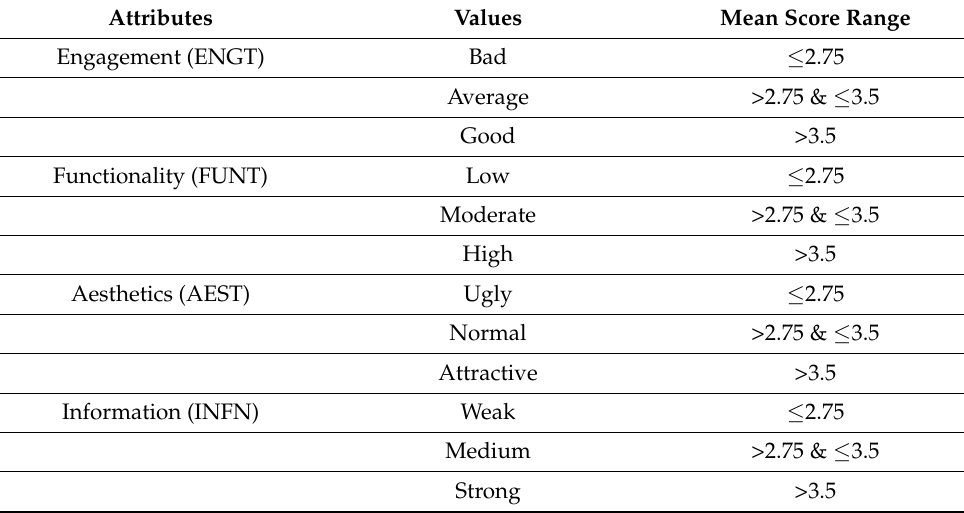
Table 4. Values assigned to attributes based on the mean